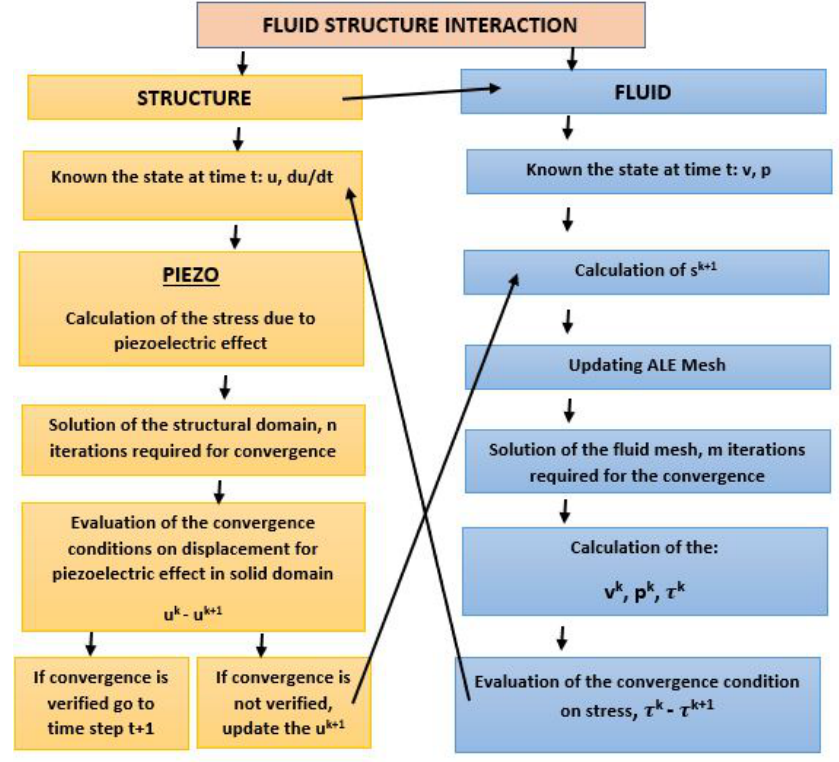
Figure 3. Overall scheme for fluid–structure interaction (FSI)-based PEH